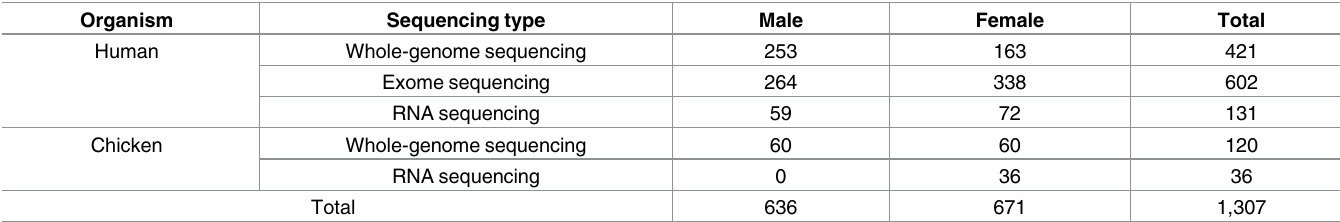
Table 1. Summaryof datasetsused for testing and